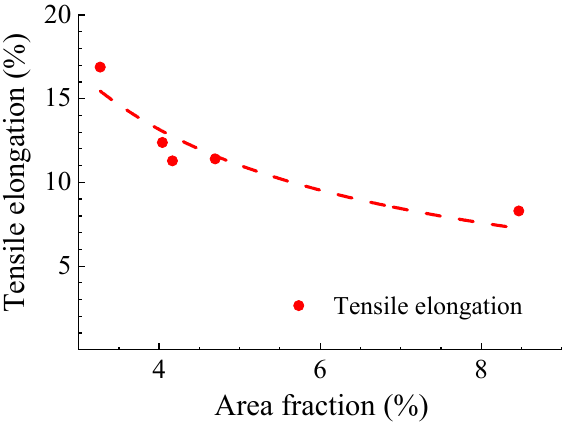
Figure 11. Ambient temperature tensile elongation of TMP alloys.